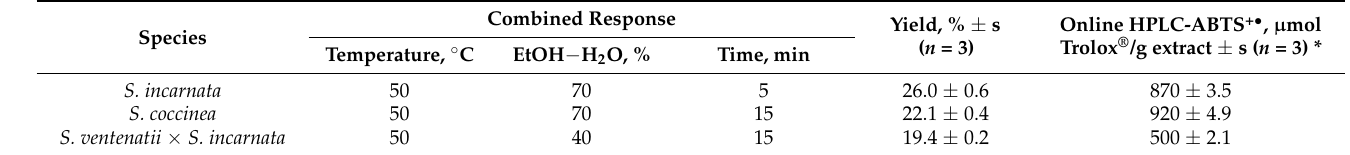
Table 2. Conditions for higher yield and antioxidant activity, measured by the online HPLC-ABTS + • assay, of Scutellaria spp.